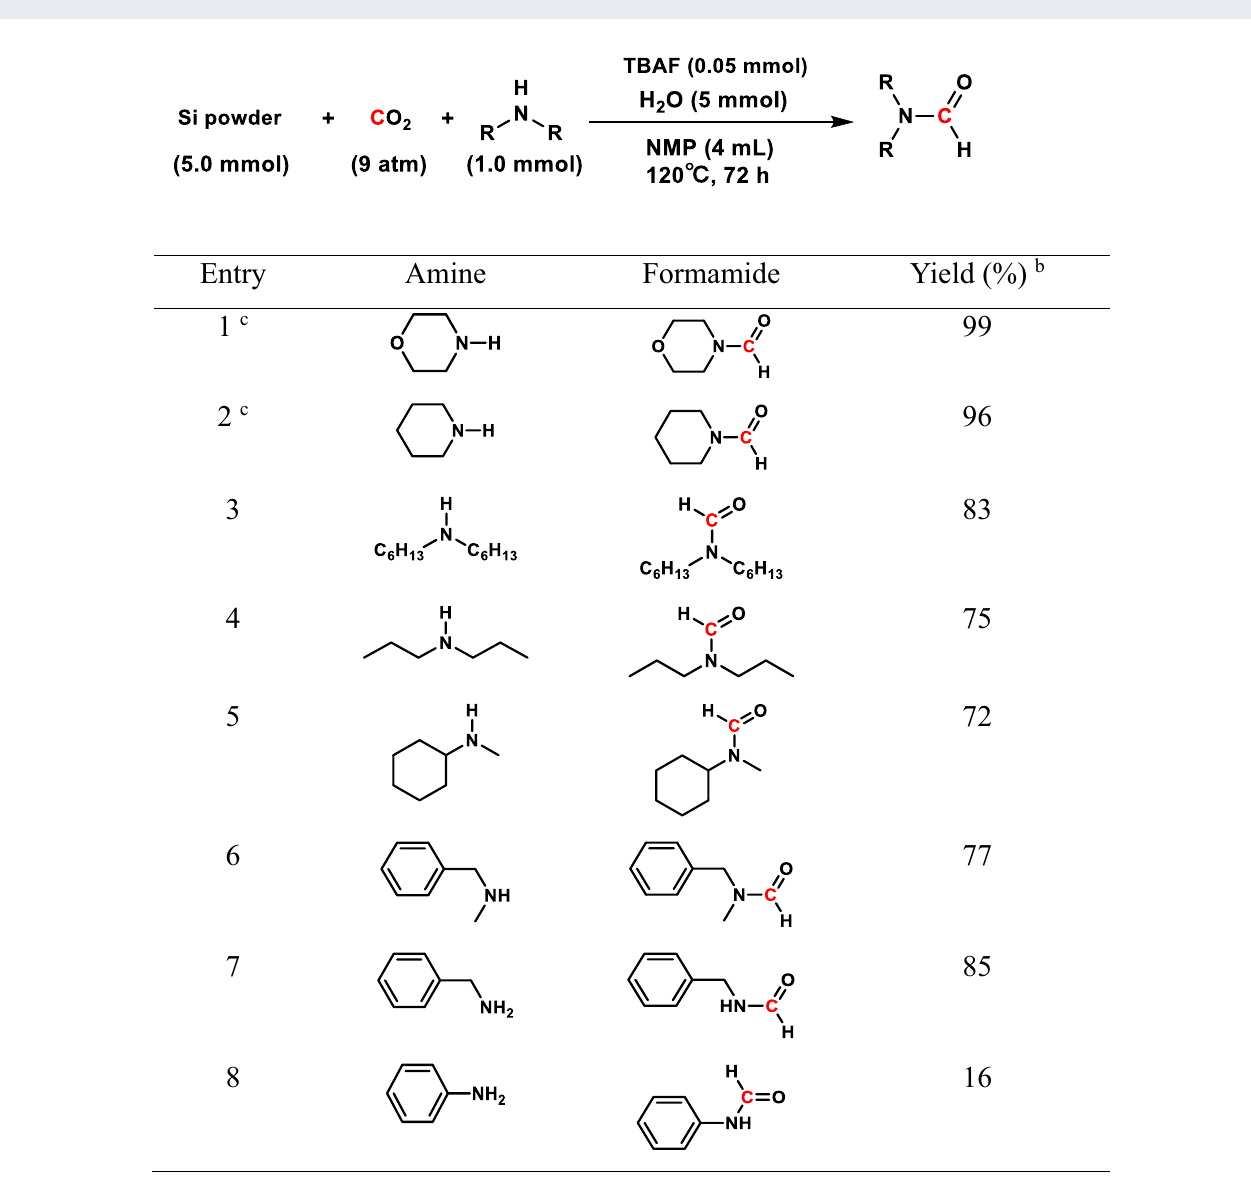
Table 4 Substrate scope of amine on CO 2 conversion to formamide a